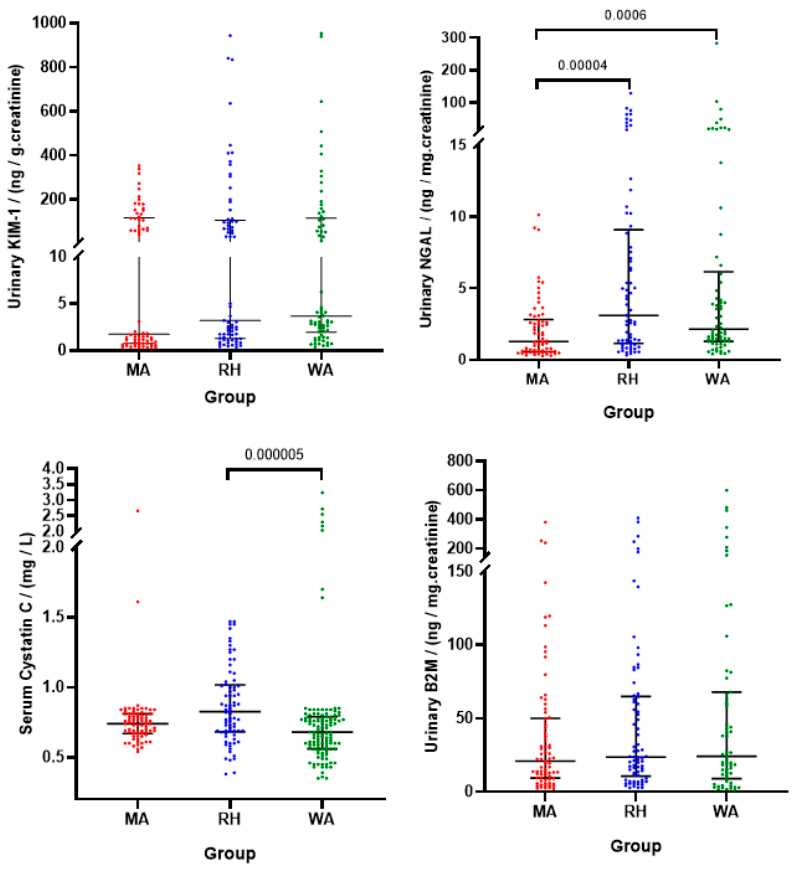
Figure 3. Renal injury biomarker levels (median and IQR) in emerging locations (Rahathangama (RH) and Warunagama (WA)) and non-endemic Matara (MA).